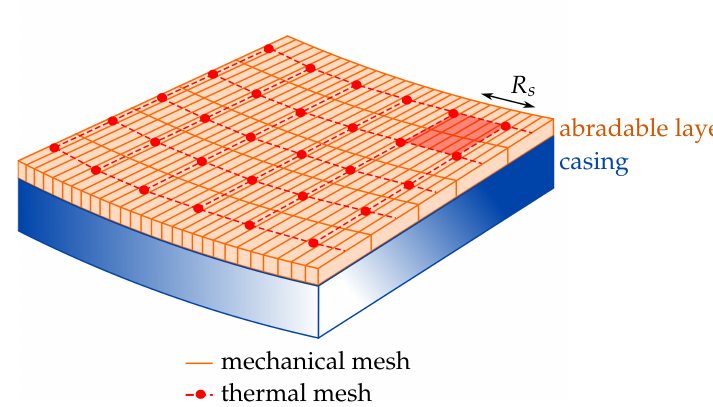
Figure 3. Superimposed mechanical and thermal